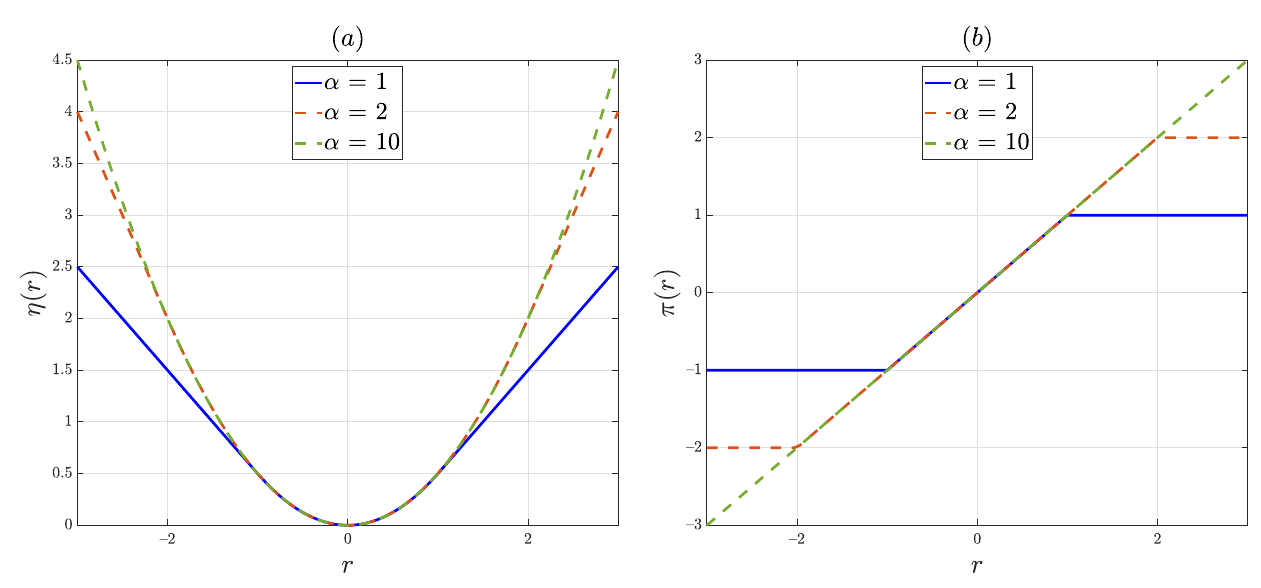
Figure 8. ( a ) Loss function η ( r ) for the Huber M-estimator. For α = 10, the penalty for large residuals is very high, implying outliers will have a significant influence on the estimation accuracy. Alternatively, one can interpret this as the (cid:96) 2 component of the Huber penalty function dominating over a wider span of residuals compared to the (cid:96) 1 component of the Huber penalty. For α = 1, the slope of the curve is less steep making the contribution of outliers less influential in the estimation performance. In this case, the (cid:96) 1 component of the Huber penalty has more influence on the estimation performance. α = 2 gives a performance that is in between the former two. ( b ) Sensitivity function π ( r ) for the Huber M-estimator. For robustness, we desire a continuous and bounded sensitivity function [46]. Since the case of α = 1 is bounded over a smaller interval of residual values, it is less sensitive to large outliers. The sensitivity increases for increasing values of α